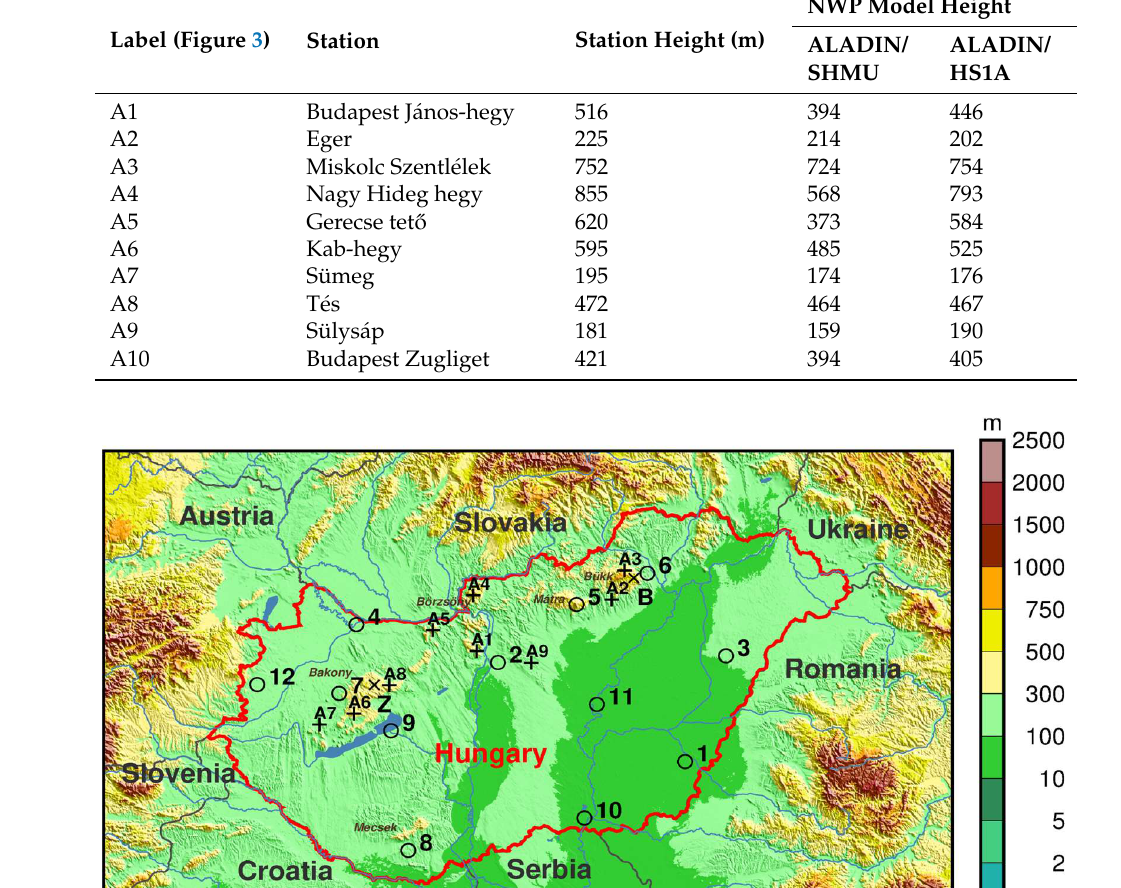
Table 2. List of AWS stations used for case studies and their a.s.l. height in meters. The A10 station (Budapest Zugliget) is not depicted on maps due to its close proximity to Budapest J á nos-hegy (1.3 km distance).